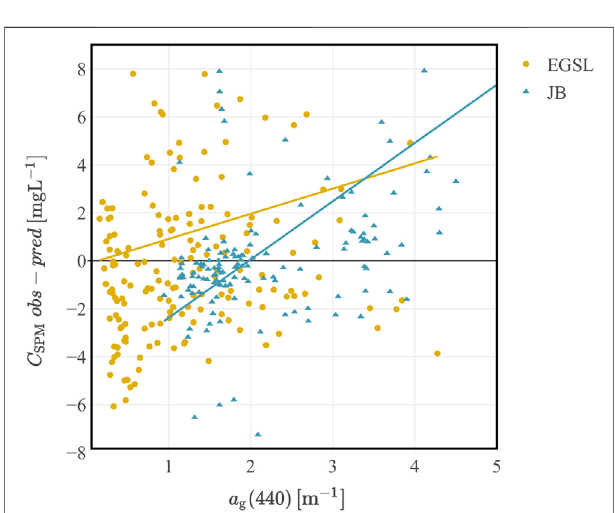
FIGURE 7 | Residuals of the relationship between C SPM and R rs (665) ( Figure 6A ) as a function of a g (440). Yellow dot represents data from the EGSL and blue represents triangle data from JB. Yellow and blue lines represents the linear regression between the residuals and a g (440) with correlationcoef fi cients( r )of0.02( p < 0.05)and0.17( p < 0.001)fortheEGSL and JB, respectively.